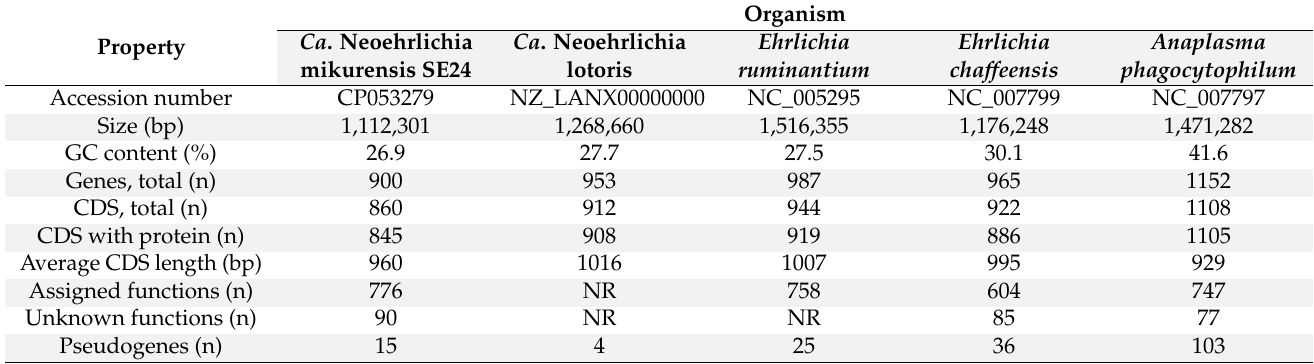
Table 2. Genome properties of Ca . N. mikurensis compared with that of other members of the family Anaplasmataceae .